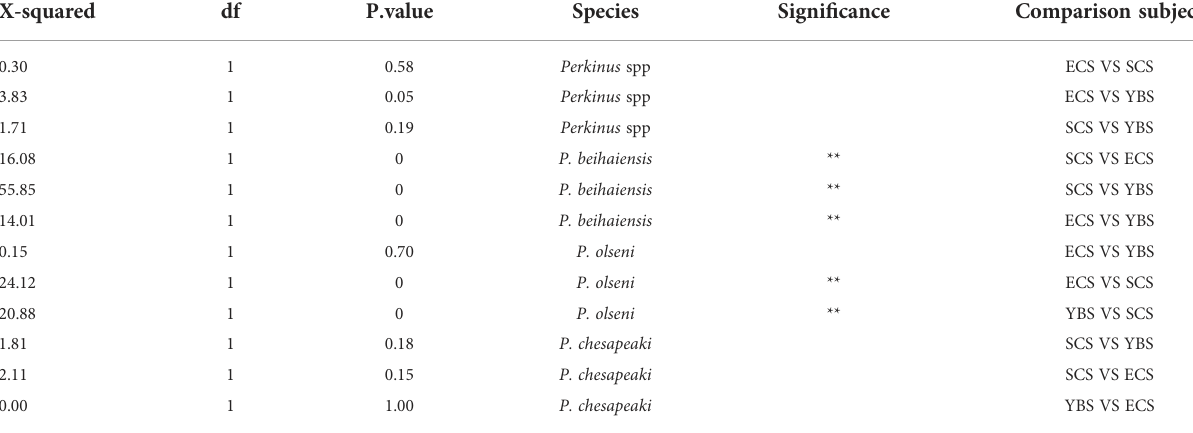
TABLE 2 Chi-square test of PCR-prevalence of Perkinsus species among different